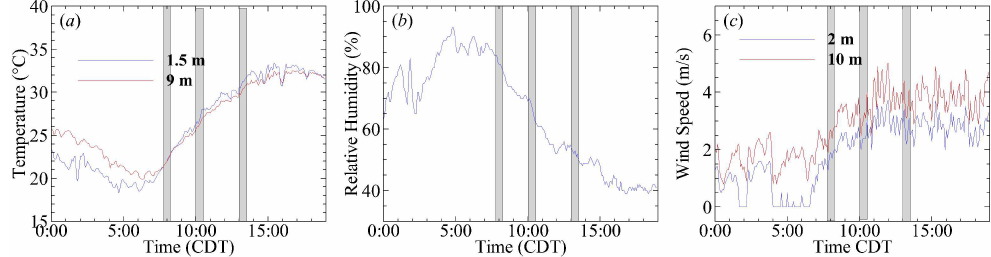
Figure 5. Data extracted from Marena Mesonet site for 29 June 2016 showing ( a ) temperature, ( b ) relative humidity, and ( c ) wind speed evolution during the day. Grey boxes show approximate times at which measurement flights occurred.